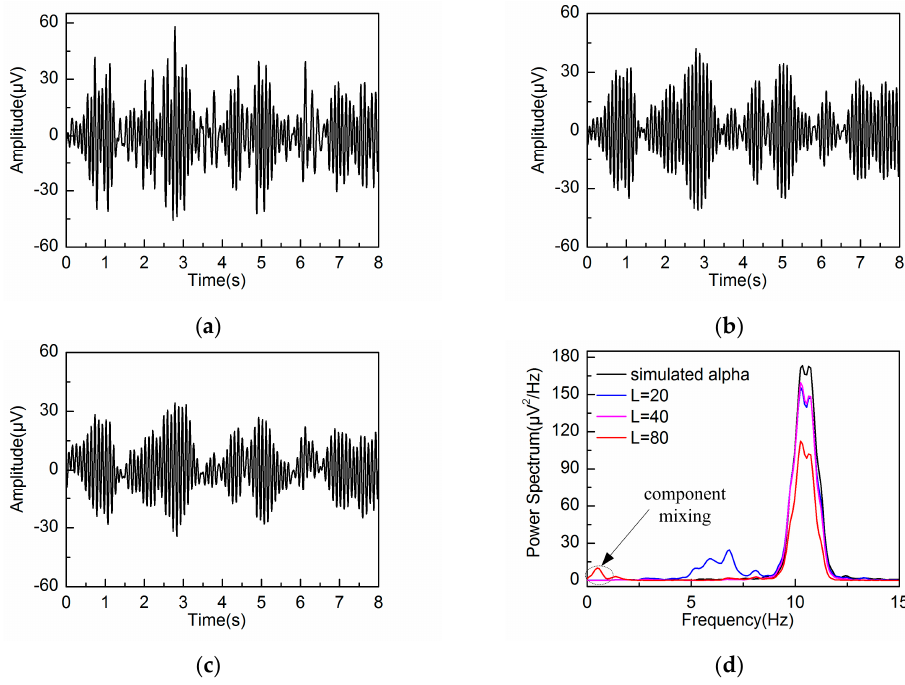
Figure 7. Extracted alpha rhythm: ( a ) L = 20; ( b ) L = 40; ( c ) L = 80; ( d ) PSD of the extracted alpha rhythm by different embedding dimensions L, as compared with that of the simulated alpha